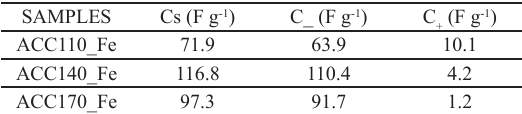
Figure 10. GCDC performed at 1 mA of ACC140_Fe sample: (a) total potential window -0.2 at 1 V; cathodic potential range (before the OCP) and (c) anodic potential range (after the Table 3. Calculated capacitance values of ACC electrodes.